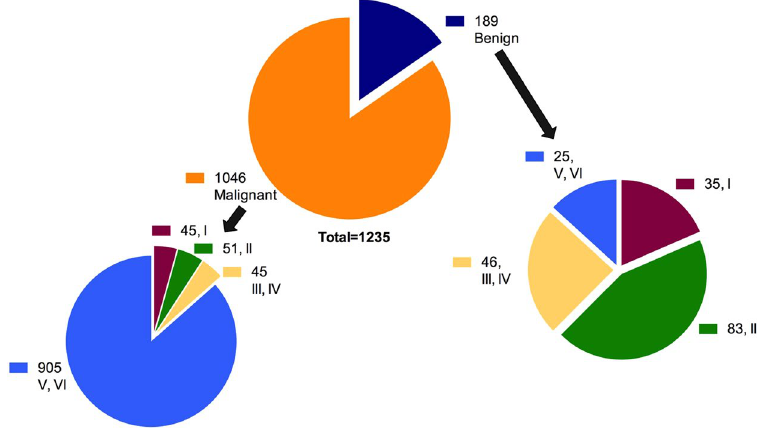
Figure 2. Benign and malignant thyroid nodules based on the Bethesda system. I, Bethesda category I; II, Bethesda category II; III, Bethesda category III; IV, Bethesda category IV; V, Bethesda category V; VI, Bethesda category